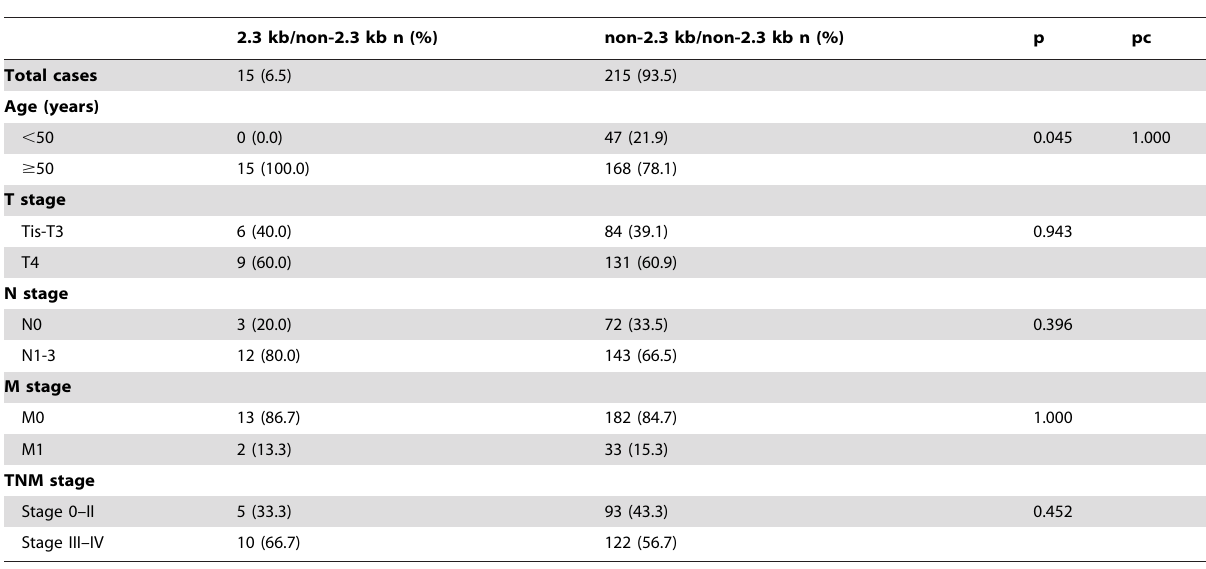
Table 5. Clinical and pathological characteristics of GC patients with MUC5AC-u repetitive region 2.3 kb allele.